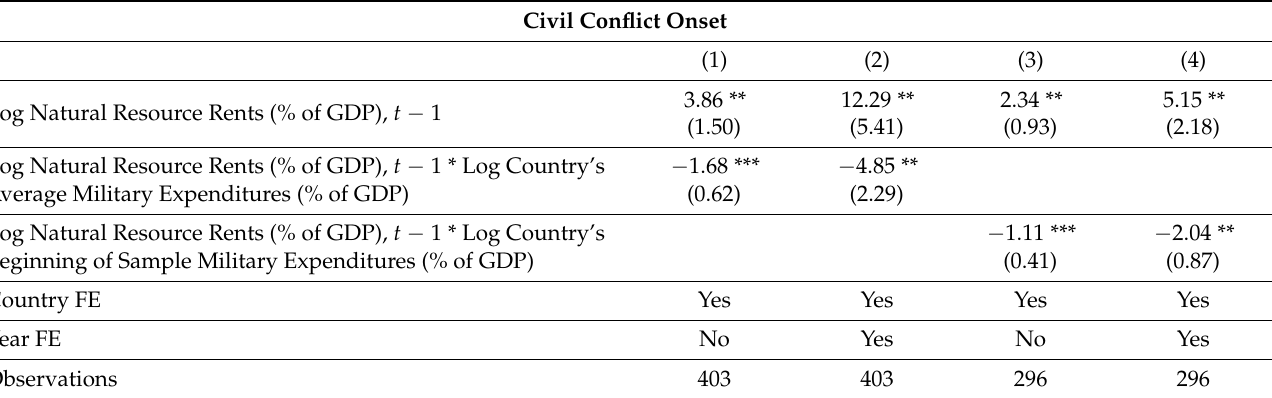
Table 10. Robustness: Middle East and North